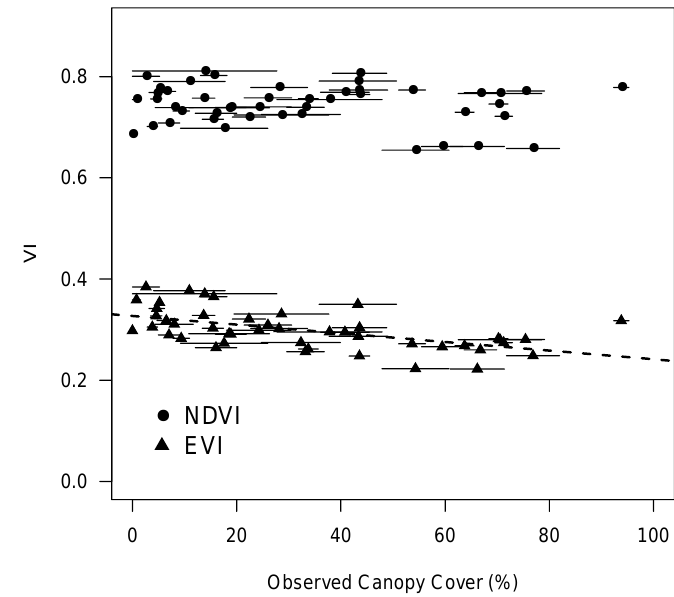
Figure 10. Relationships between Landsat Vegetation Indices (VI) from 28 July 2017 image and observed canopy cover. Dashed lines show statistically significant relationship ( p < 0.05). Horizontal whiskers indicate standard error (SE) of mean canopy cover.